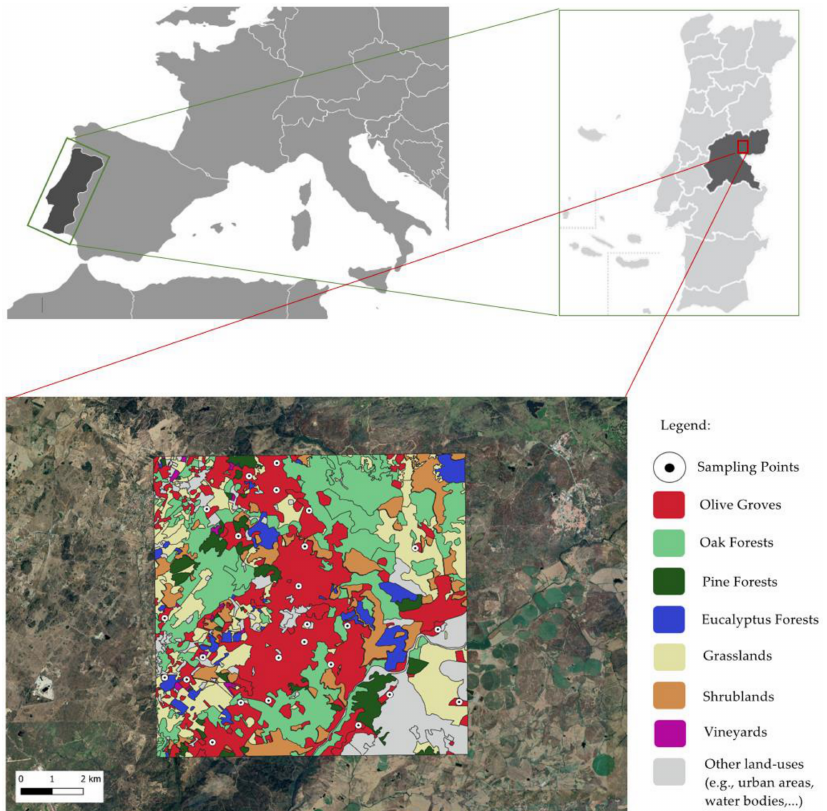
Figure 1. Illustrative representation of the exact location of the twenty-five sampled olive